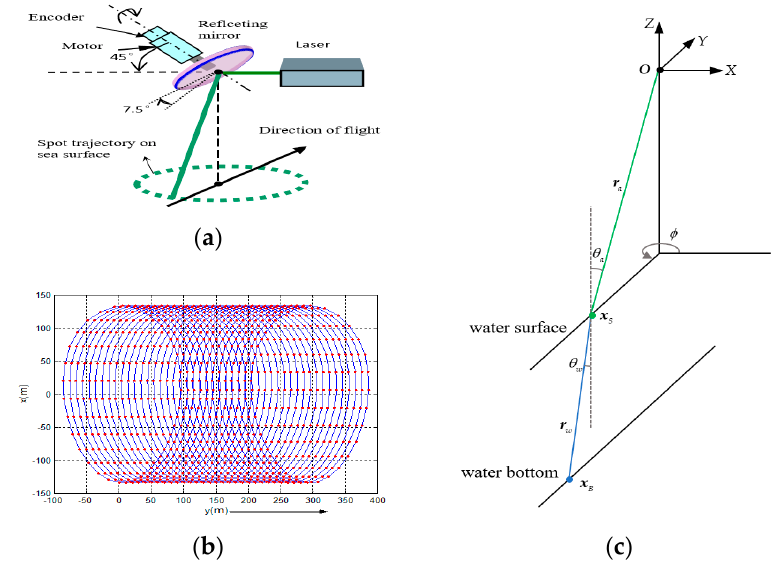
Figure A2. ( a ) The rotating scanner of Mapper5000 and ( b ) the spot trajectory on sea surface. The angle between the normal of the reflecting mirror and the axis of rotation is 7.5°, resulting in an elliptical spot trajectory on the sea surface [44]. ( c ) The mechanism of the refraction correction for Mapper5000. The ray path of the green laser in air and water are denoted by green and blue line, respectively.